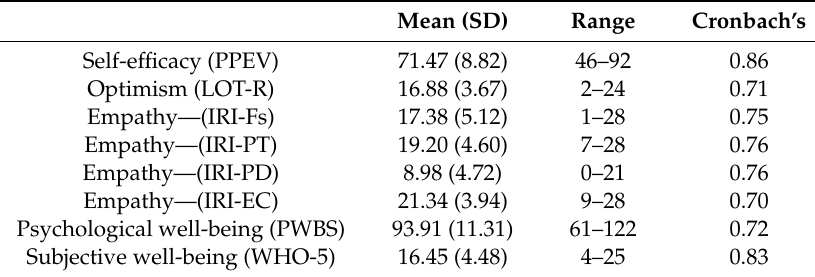
Table 2. Descriptive statistics of psychological